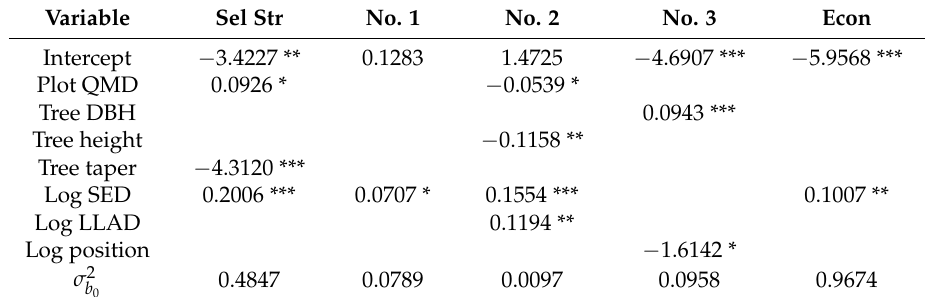
Table 5. Selected parameters and level of significance for lumber visual grade presence/absence